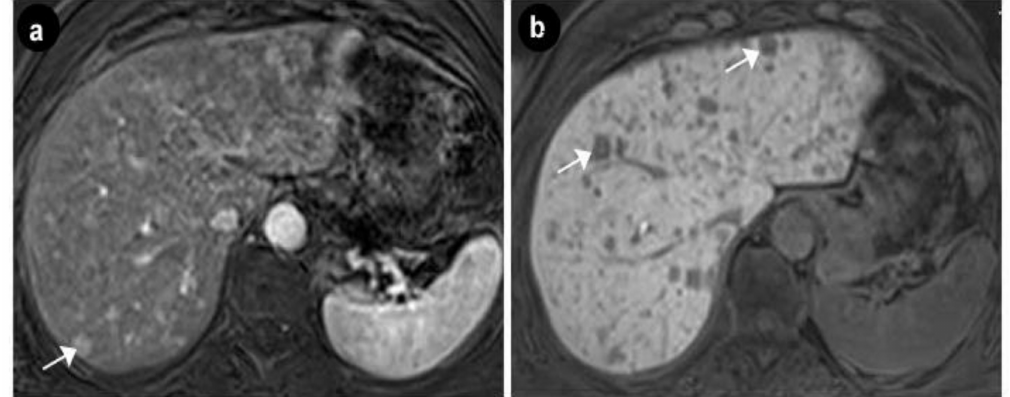
Figure 6. Axial MRI exam—multiple hepatic nodular lesions suggesting miliary metastic disease. ( a ) Gadolinium enhanced T1w showing hypervascular lesions (arrow). ( b ) T1w image, hepato-biliary phase after gadolinium enhancemet, showing hypointense lesions suggestive of the tumoral etiology